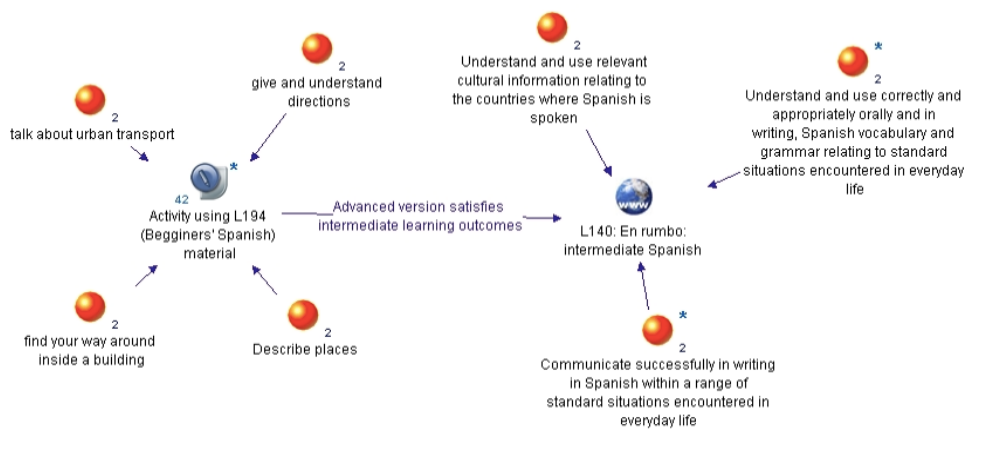
Figure 9 . An example of a CompendiumLD